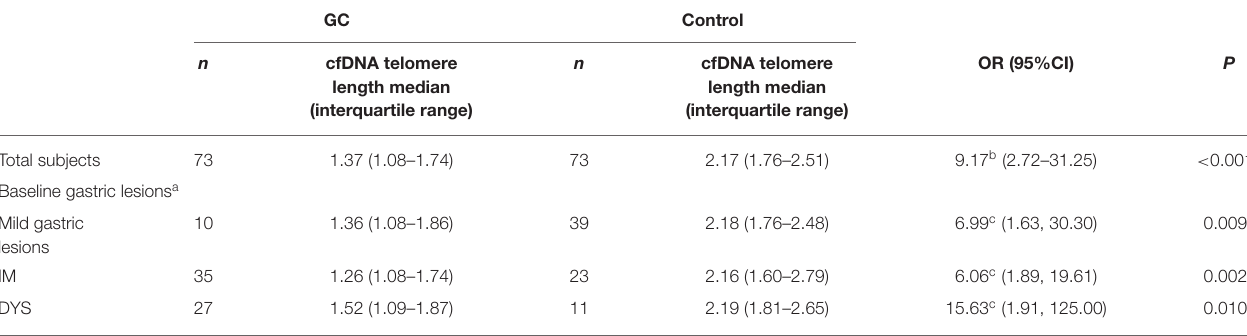
TABLE 4 | Associations between telomere length of cfDNA and GC risks.